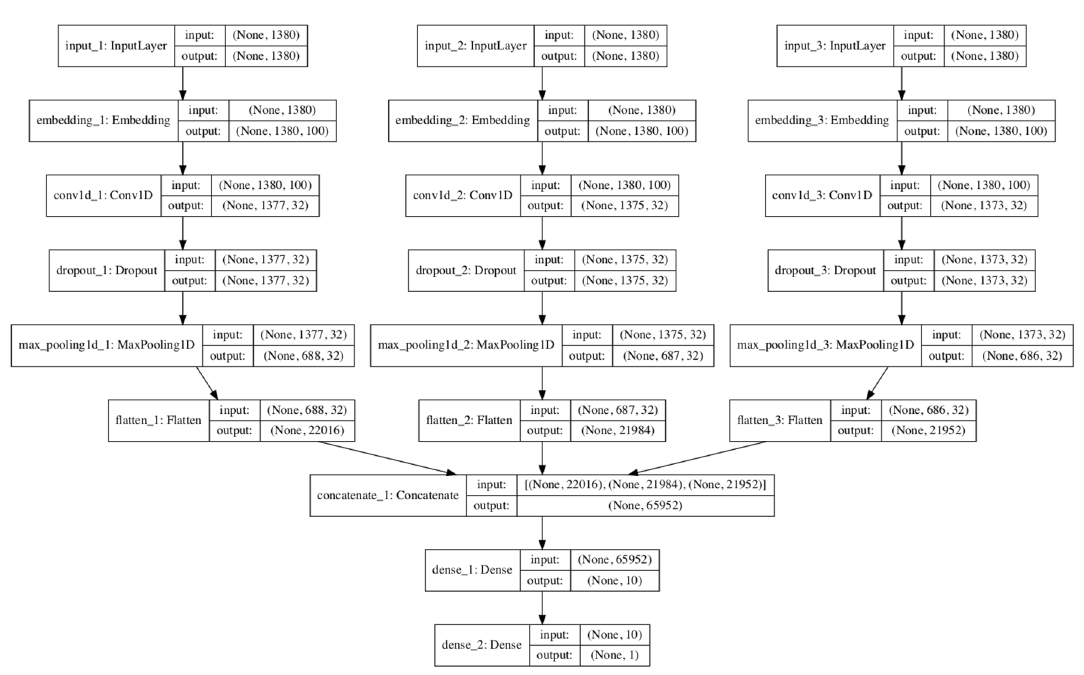
Figure 4. Architecture of multi-channel